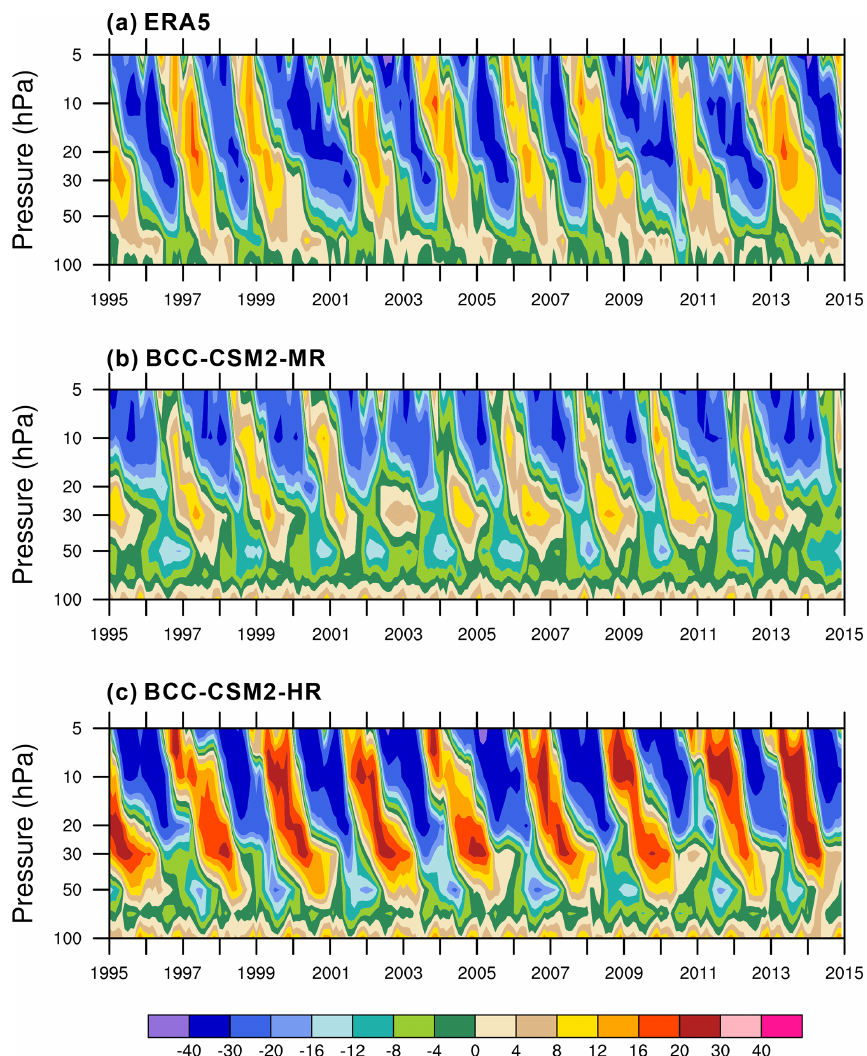
Figure 18. Tropical zonal winds (ms − 1 ) between 5 ◦ S and 5 ◦ N in the lower stratosphere for (a) ERA5 reanalysis, (b) BCC-CSM2-MR, and (c) BCC-CSM2-HR during the period from 1995 to